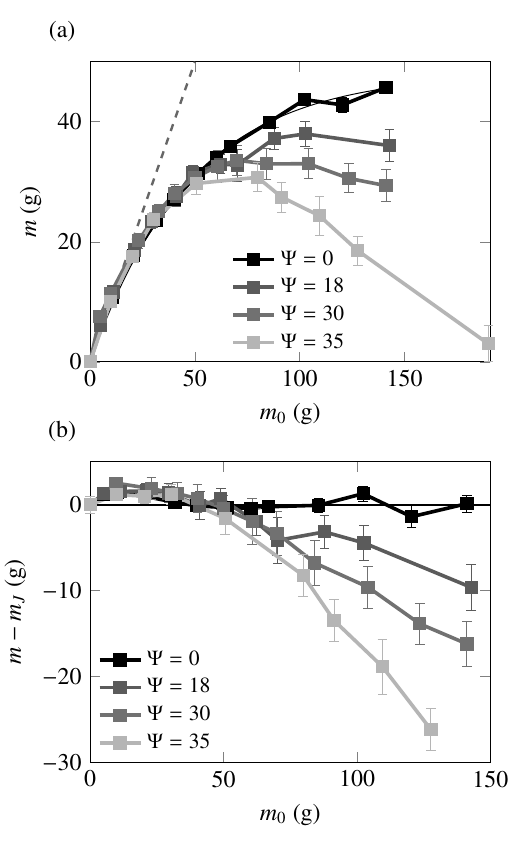
Figure 2. (a) Apparent mass measured using our experimental setup for di ff erent magnetic field amplitude, the black continuous line corresponds to the Janssen model m J and the grey dashed line represents the hydrostatic limit. (b) Mass di ff erence between the apparent mass of the system and the Janssen expression m J for di ff erent magnetic field amplitude. Figure 3. (a) Ferromagnetic dipolar interaction for a vertical